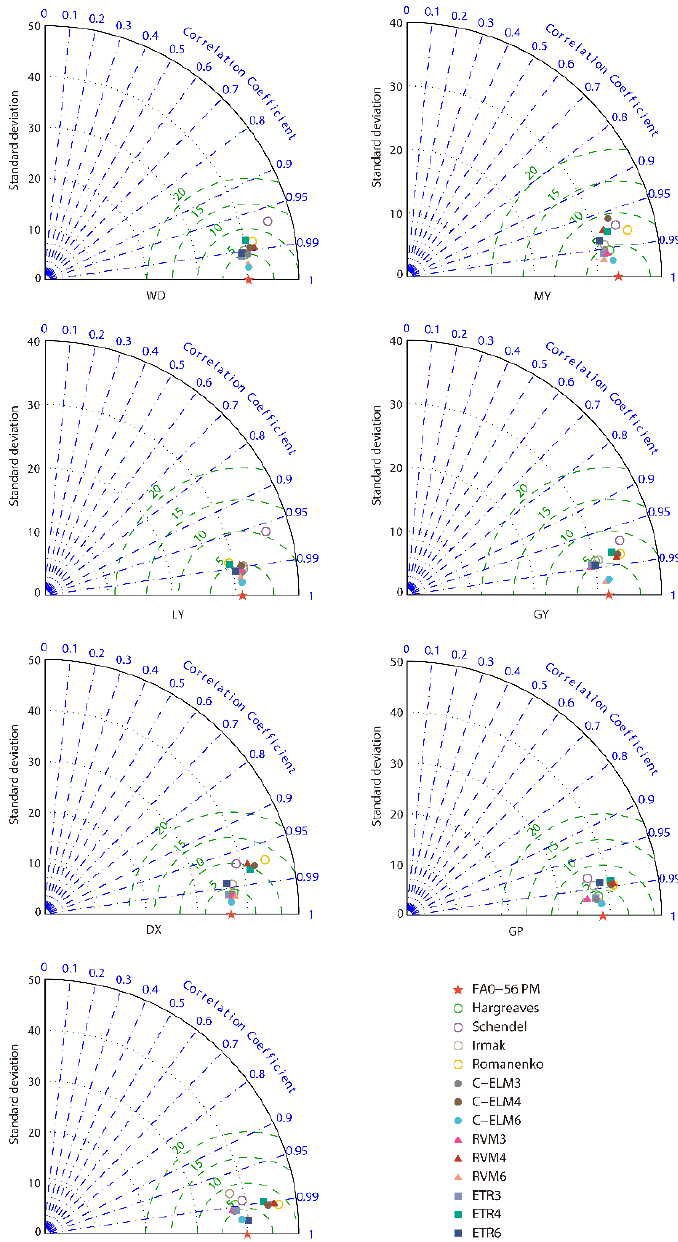
Figure 8. Taylor diagrams for the four empirical equations and RVM, C-ELM, and ETR models for predicting ET 0 at the seven stations.